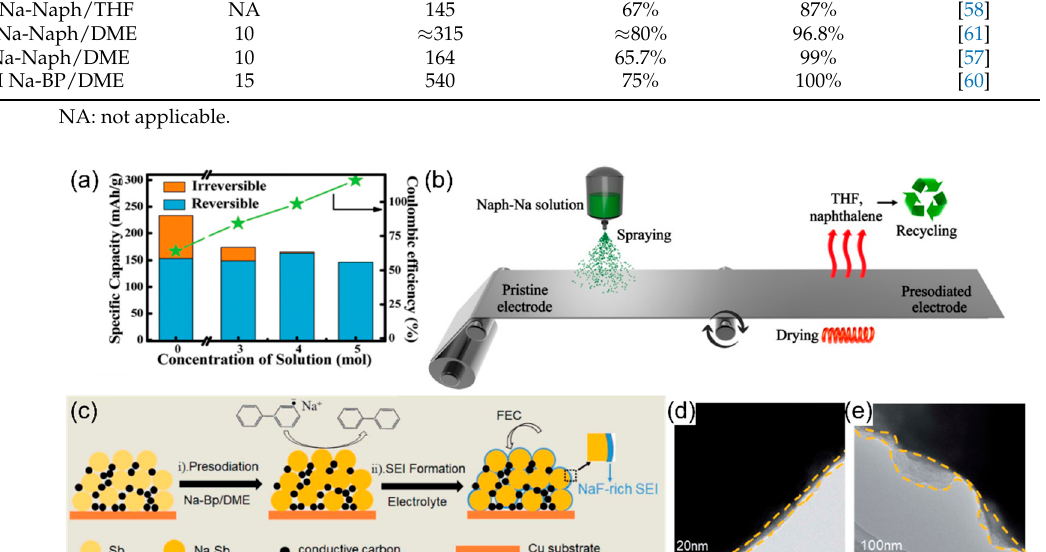
Figure 8. ( a ) Comparison of the specific capacity and Coulombic efficiency after the anode presodi- ation with different concentrations of the Na-Naph solution. Reproduced with permission from